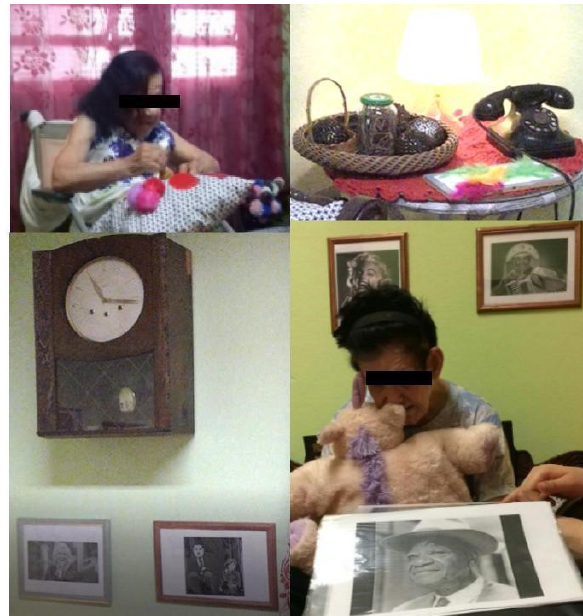
Figure 2. The vintage room had decoration features from the 1940s to 1960s, a photo album, flavored sachets and topiaries, tactile pillows, feather fan, stuffed animal, thermal bag and hand massager, ambient music, and a